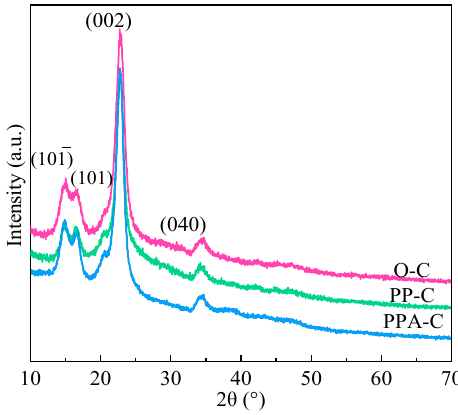
Figure 2. The XRD spectrum of fabrics.